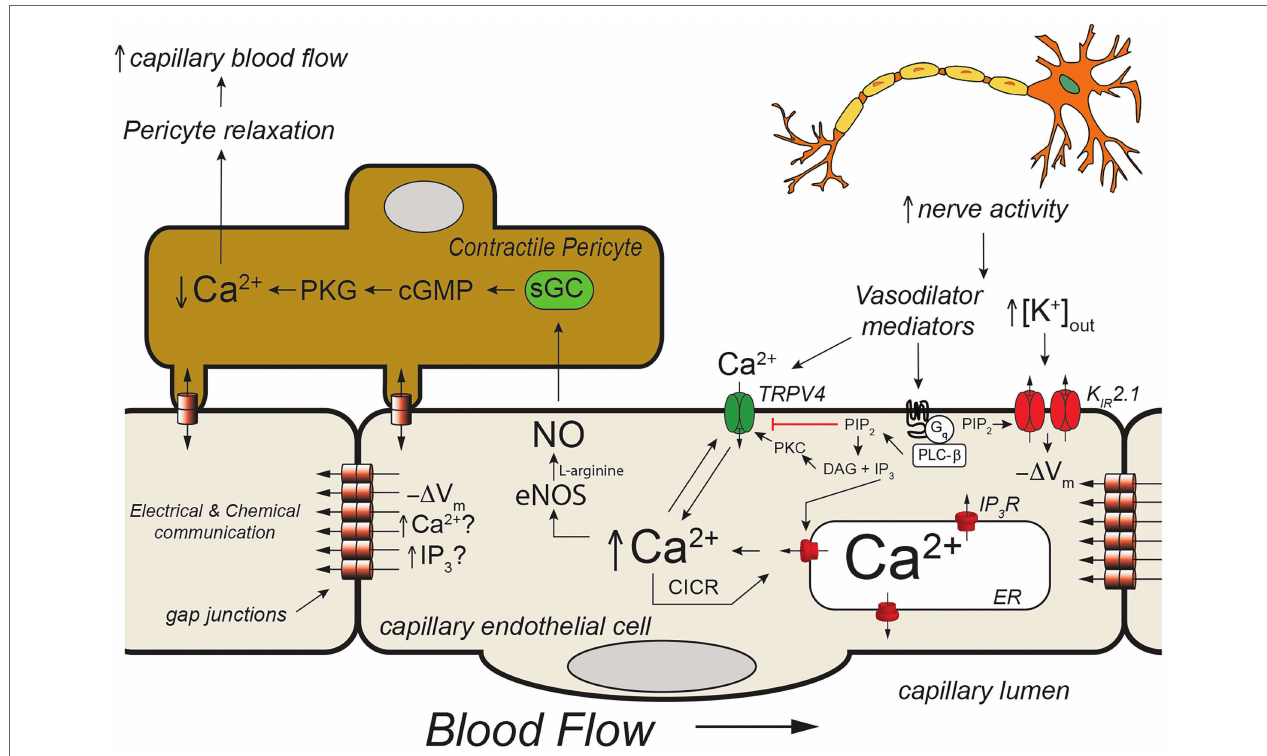
FIGURE 4 | Capillary Ca 2+ signaling to control pericyte contraction. Schematic of a capillary segment invested with a contractile pericyte. Increased nerve activity will result in accumulation of extracellular K + (as in Figure 2 ) and a yet unidentified mediator (like PGE 2 , for example). The increase in [K + ] out will hyperpolarize the membrane ( −Δ V m ) as in Figure 2 . The mediator will activate G α q -coupled receptors, leading to hydrolysis of membrane phosphatidylinositol 4,5-bisphosphate (PIP 2 ) to form IP 3 and diacylglycerol (DAG). The IP 3 will activate IP 3 R in the endoplasmic reticulum resulting in Ca 2+ release. The increase in [Ca 2+ ] in , along with reduced membrane